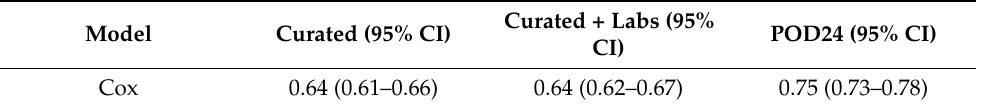
Table A3. Cox model performance (AUC) on different datasets using multiple imputation instead of a random forest imputation algorithm.